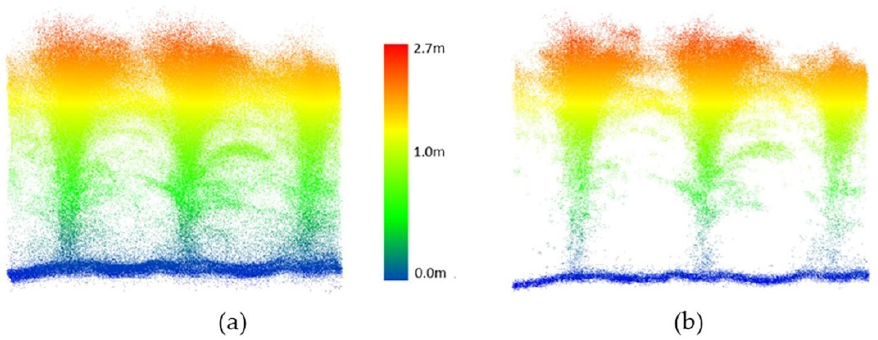
Figure 14. PhenoRover LiDAR data over maize (DAS:62). ( a ) Original data, ( b ) point cloud after outlier removal.